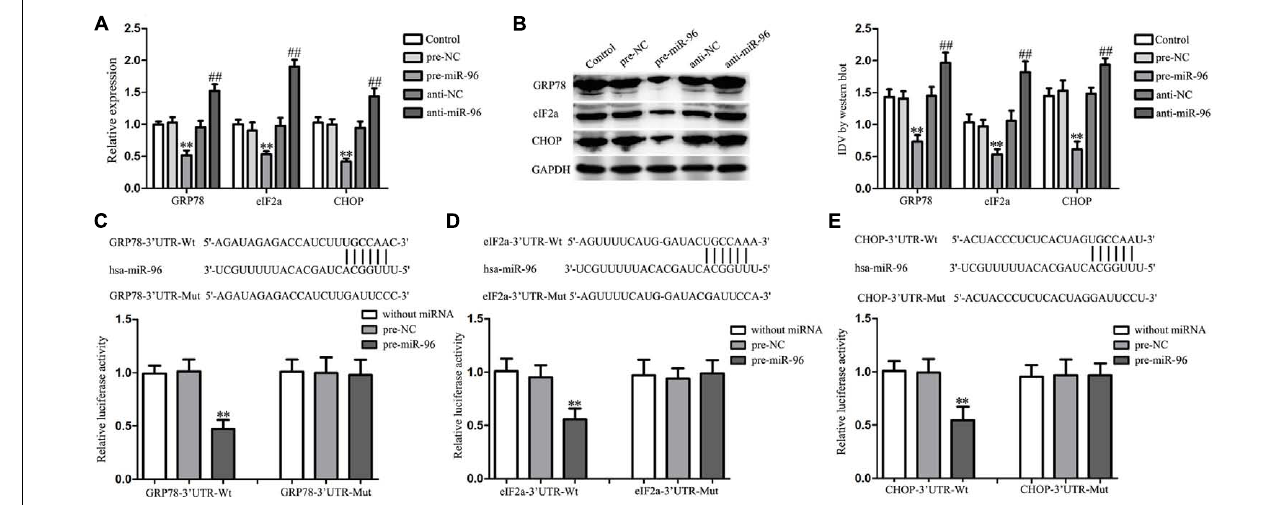
FIGURE 8 | Effect of miR-96 on the expression of UPR-related proteins (GRP78, eIF2 α , and CHOP) in GECs, and miR-96 targeted the 3 (cid:48) -UTR of UPR-related proteins. (A) Quantitative real-time PCR assay to evaluate the effect of miR-96 on the mRNA expression of UPR-related proteins (GRP78, eIF2 α , and CHOP) in GECs. (B) Western blot assay to evaluate the effect of miR-96 on the protein expression of UPR-related proteins (GRP78, eIF2 α , and CHOP) in GECs. Data represent means ± SD ( n = 5, each). ∗∗ P < 0.01 vs. pre-NC group, ## P < 0.01 vs. anti-NC group. (C–E) Schematic representation of the putative binding site for miR-96 in the 3 (cid:48) -UTR of UPR-related proteins (GRP78, eIF2 α , and CHOP) and the site mutagenesis design for the reporter assay. Luciferase reporter assay of HEK 293T cells co-transfected with the pmirGLO vector constructed with either wild-type fragments or mutation fragments and indicated miRNAs. Renilla/firefly luciferase ratios were calculated and further normalized to the without miRNA group which was set as 1. Data represent means ± SD ( n = 5, each). ∗∗ P < 0.01 vs. pre-NC